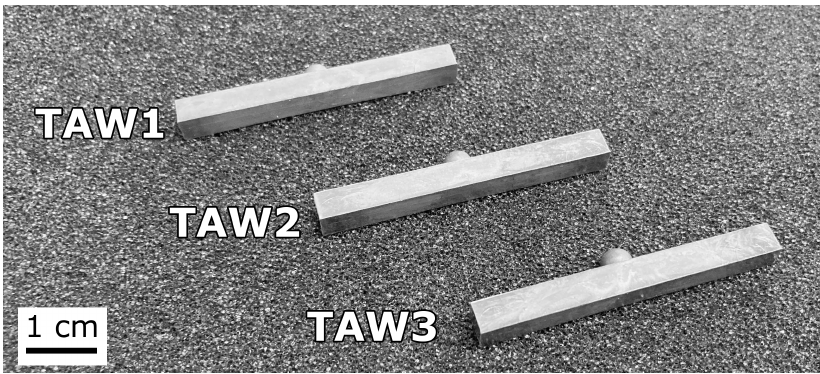
Figure 1. Typical PIM samples obtained using different EEW